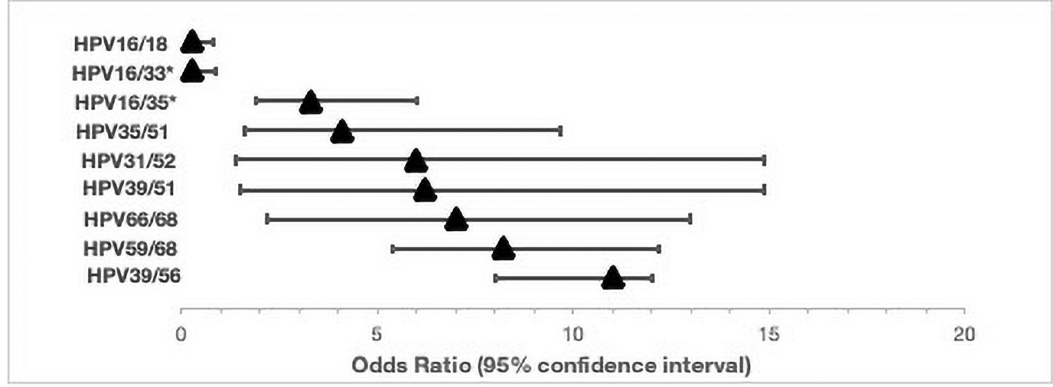
Fig 4. Odds ratios and 95% confidence intervals (95% CI) for co-occurrence of high-risk HPV infections among Zimbabweans. � Indicates co-segregation of HPV genotypes in the same phylogenetic